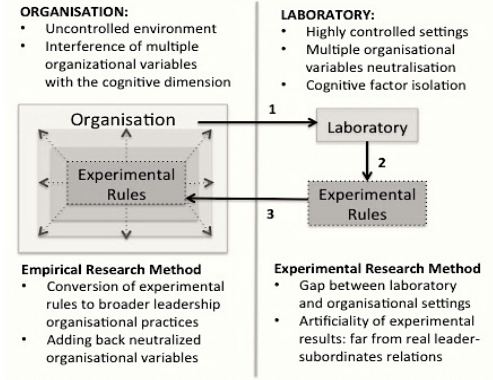
Fig. 1. A research method to highlight leadership for creativity in organizations using laboratory